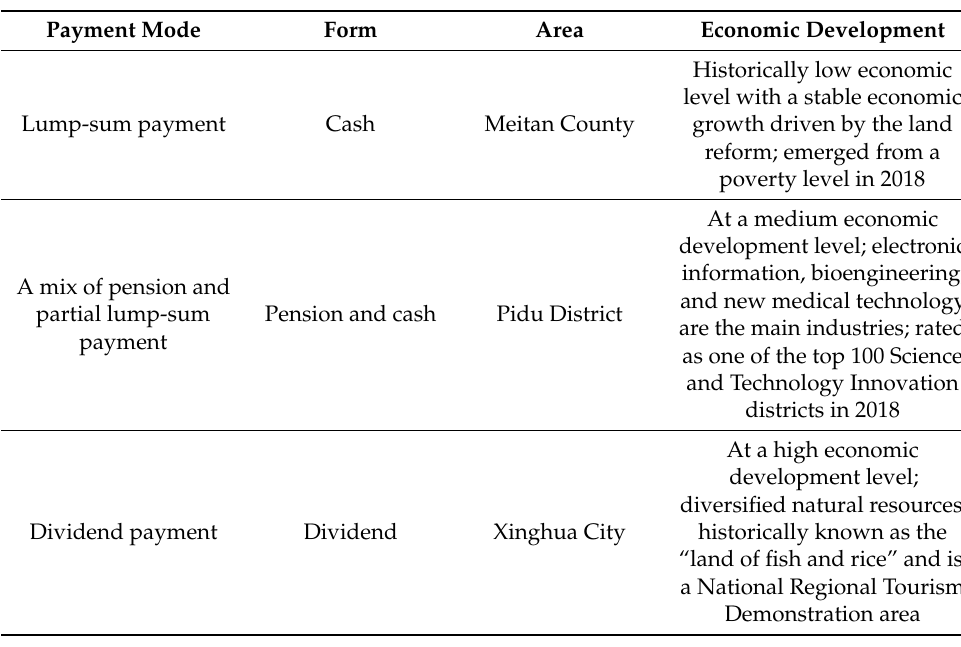
Figure 2. Locations of Meitan County, Pidu District, and Xinghua City. Table 1. Comparison of three payment